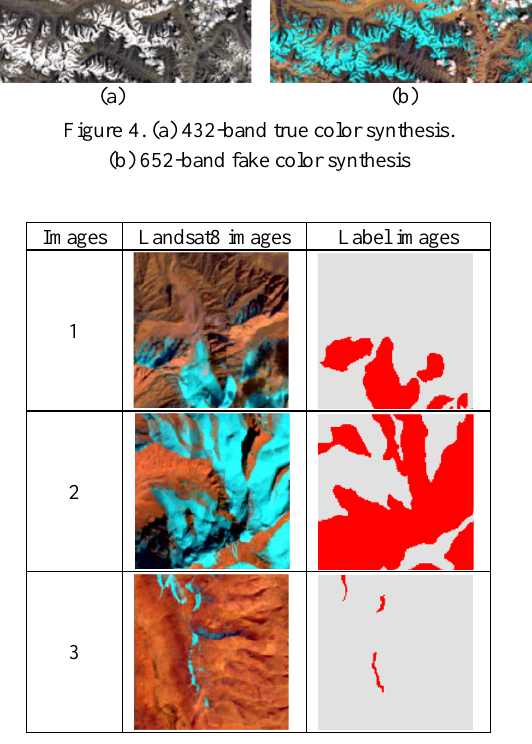
Figure 5. Examples of the training samples